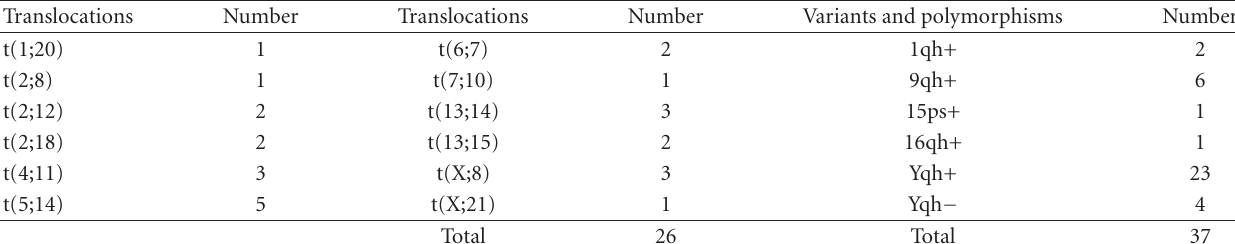
Table 3: Translocations and variants in the